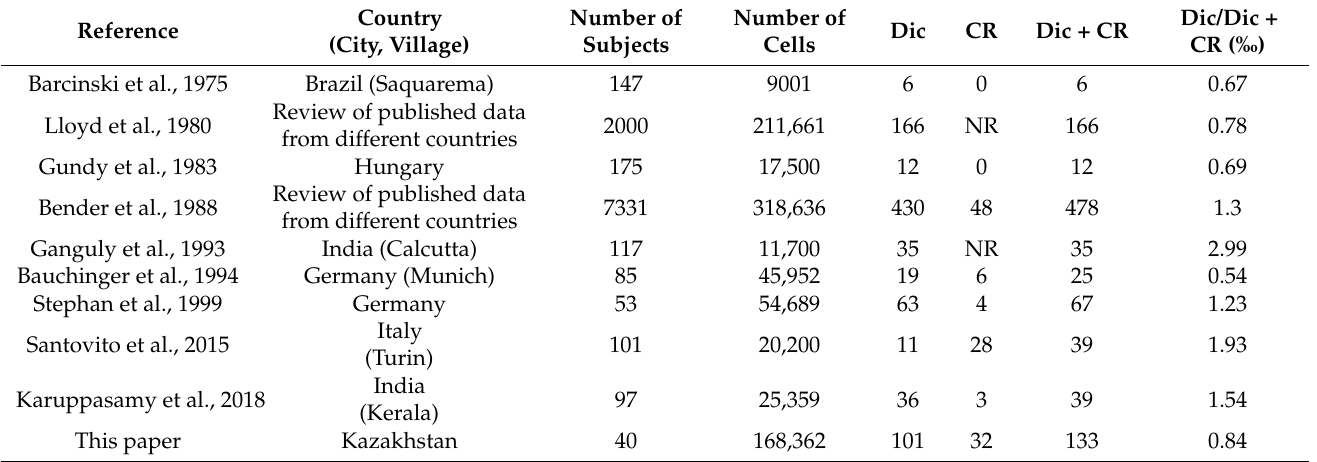
Table 4. Chromosome aberration background frequencies in control subjects from different